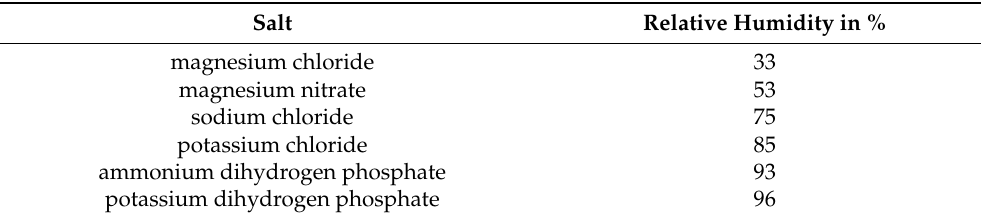
Table 2. Used salts for salt solutions and the regulated relative